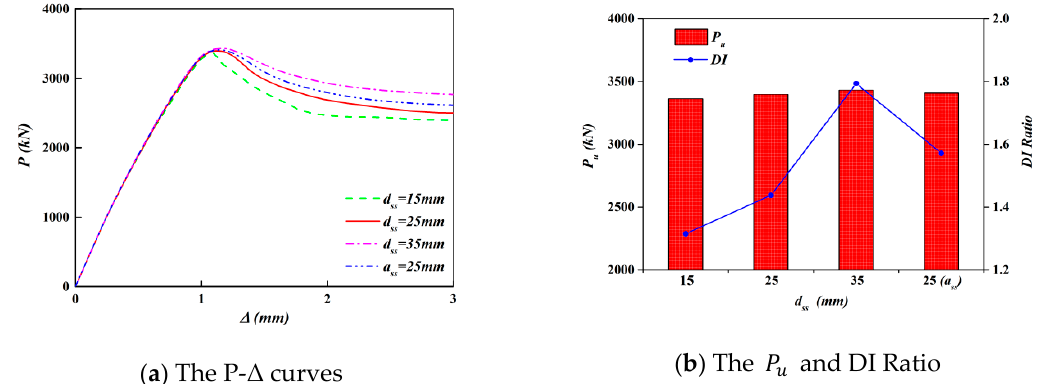
Figure 20. Influence of the diameter (side length) of steel sheets on compressive resistance of SDC wall.